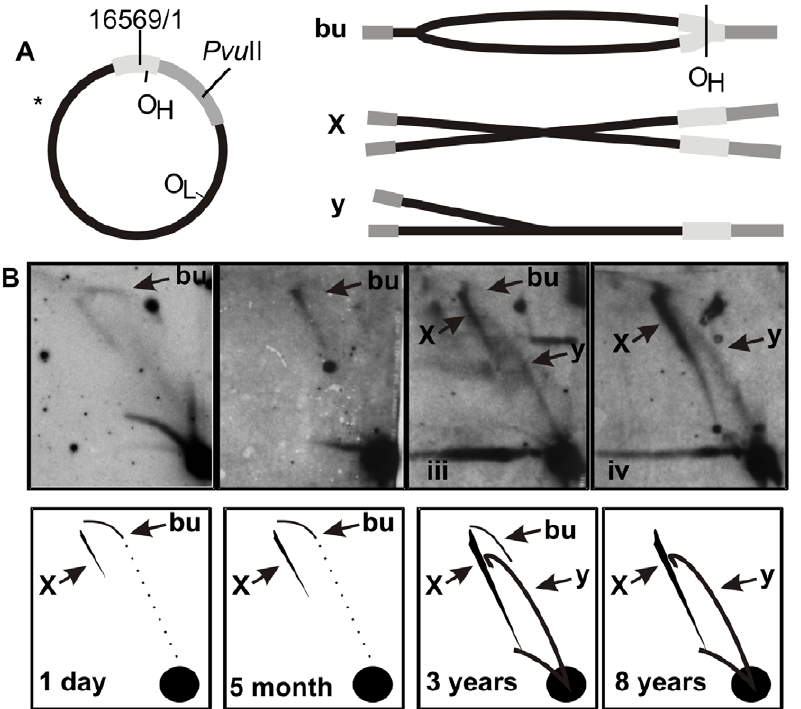
Figure 2. Theta-type mtRIs in infant heart. (A) A diagram of human mtDNA showing the probe location (*), the Pvu II cut site (nt 2565) and the resulting molecular forms after digest. In the case of unidirectional theta-replication originating from the O H , the molecules containing replication bubbles form almost complete bubble-arc (bu) on the 2D-AGE. Y- or Y-like arc likely results from initiation outside O H but can in the case of human heart mtDNA also contain more diverse forms of mtRIs (see [5] for further explanation). (B) Single-cut Pvu II 2D-AGE analysis of the samples in Figure 1. Faint bubble-arcs seen at younger age are gradually replaced by X- and Y-forms of much stronger intensity. Heart mtRIs from children aged 8–10 years show no difference to the adult mtRI forms.